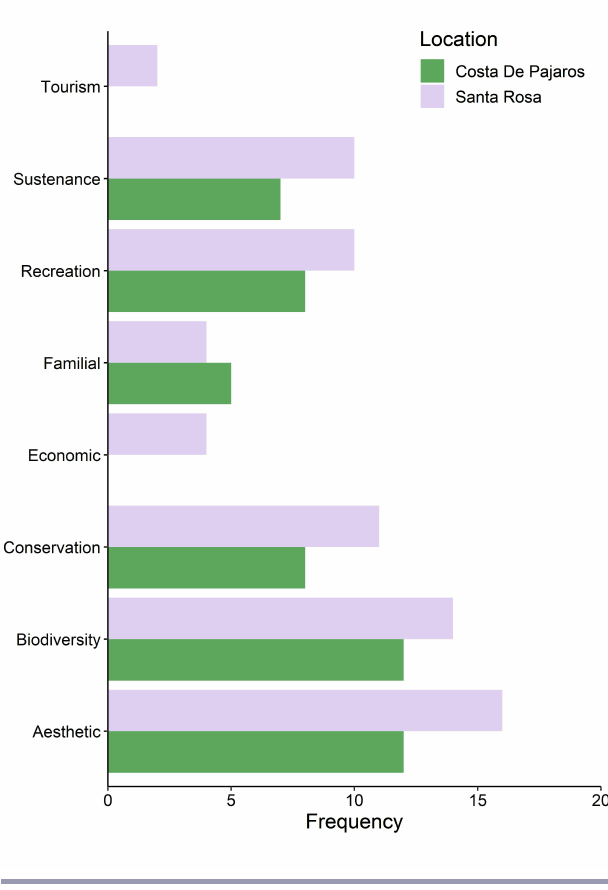
Fig. 3 . Code breakdown of photographic responses to the question, "When or where do you feel most connected to the environment?" Frequency refers to the number of times a code was raised by different members of the